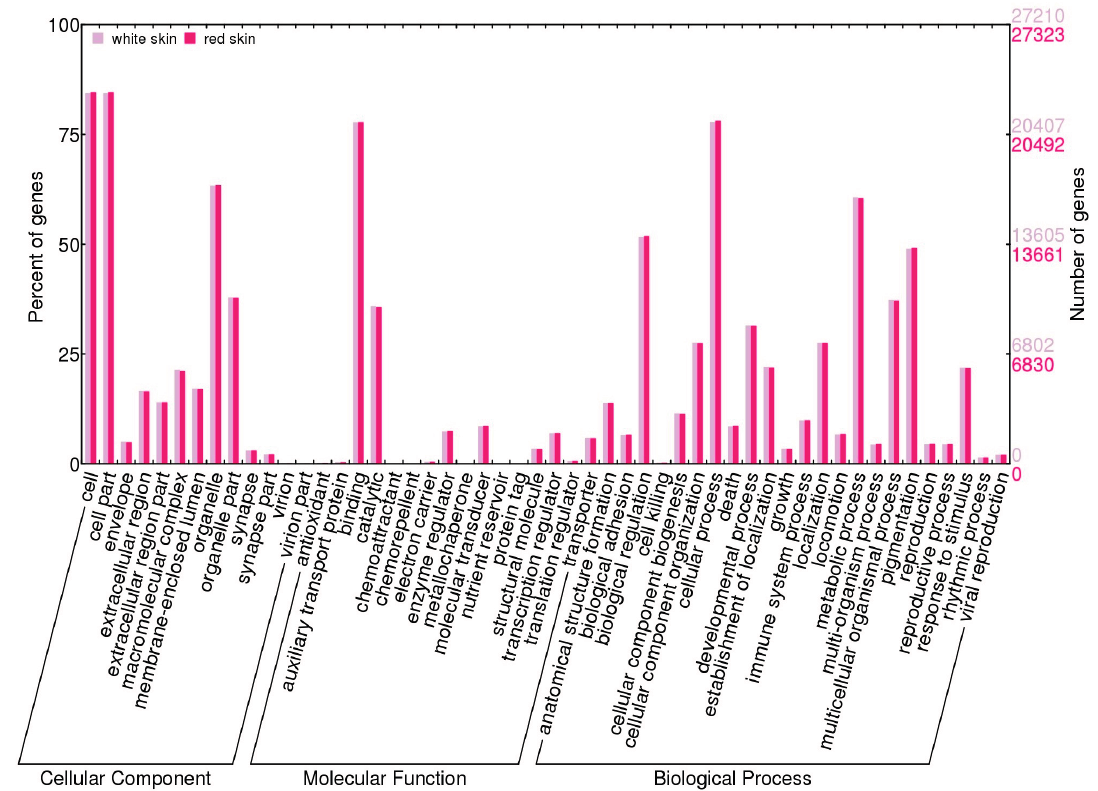
Figure 2. GO terms distribution in red skin and white skin. GO categories of genes in red skin ( red ) and white skin ( grey ). Genes were classified into three categories according to GO terms: cellular component, molecular function and biological process. The right panel and the left panel showed the number of mapped genes to the GO term and the proportion of them among all genes,